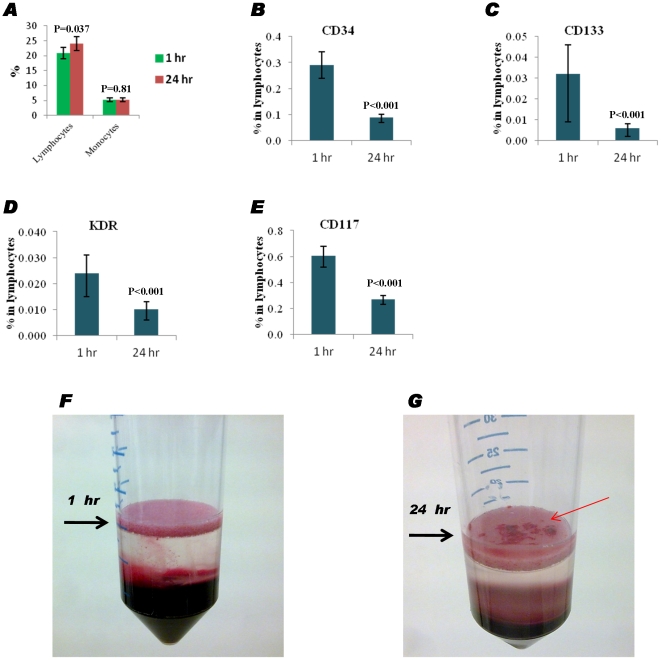
Effect of blood storage time on CPC profiling.Peripheral blood samples from MI patients were processed either directly (<1 hr) or stored at 4°C for 24 hr before analysis. (A) Bar graph showing the percentage of lymphocyte and monocyte cell populations. (B, C, D and E) Bar graph showing the percentage of CD34-PE-Cy7, CD133-APC, KDR-FITC and CD117-PE in lymphocytes, respectively before and after storage for 24 hrs. (C and D) Representative images show that there was excessive clotting in the Leucosep tubes after leukocyte isolation when samples were stored for 24 h at 4°C. Data are presented as geometric means with 95% confidence intervals.